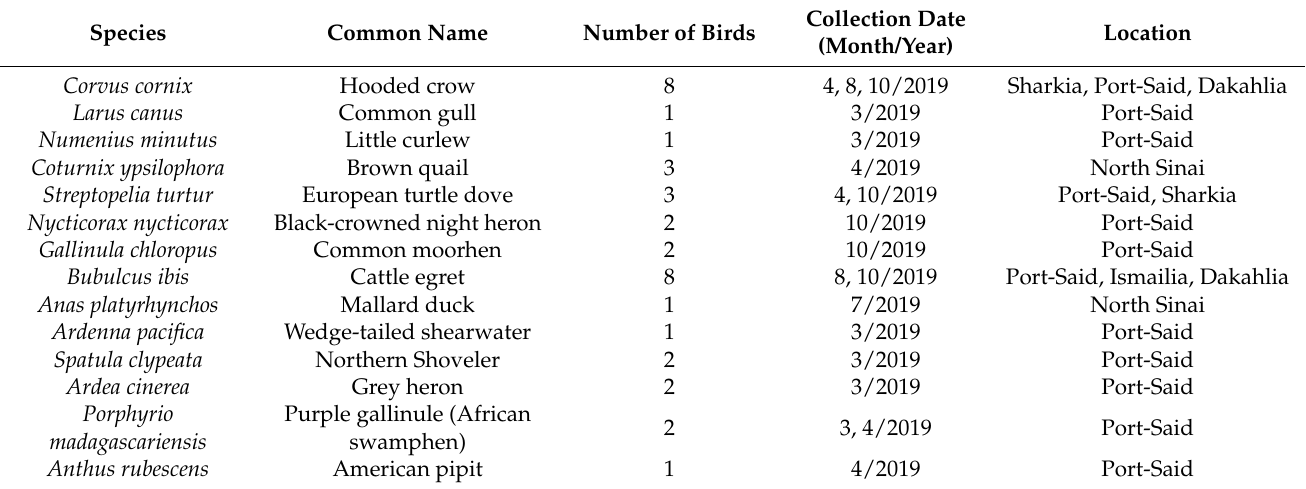
Table 2. Details of collected samples from wild birds, including order, species, common name, location of capture, collection date, and number of captured